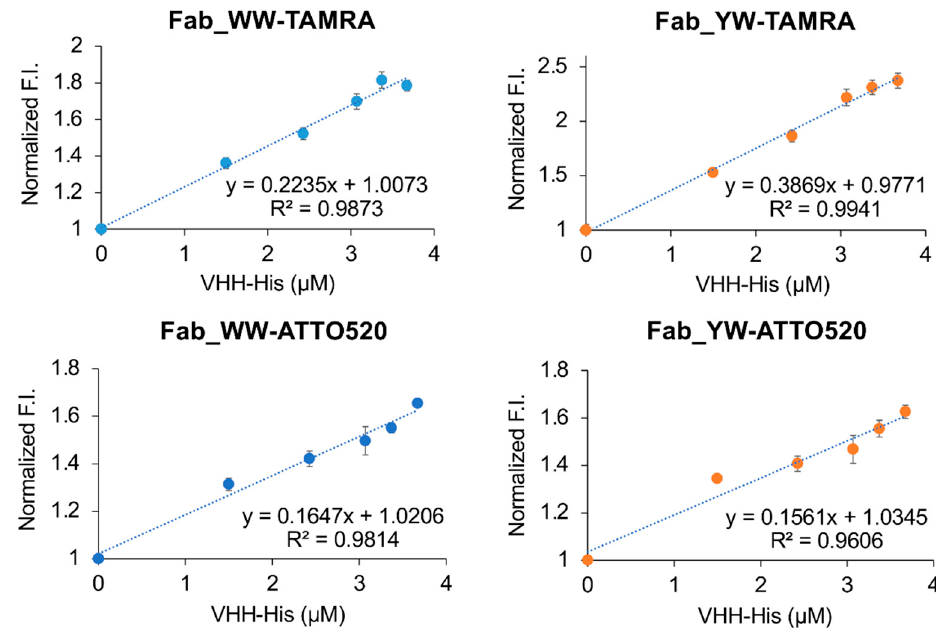
Figure 7. The relationship between the fluorescence intensity displayed by Q-body in 50% M9 culture medium and the concentration determined by a CBB-stained SDS-PAGE gel with known amounts of bovine serum albumin (BSA) standards.